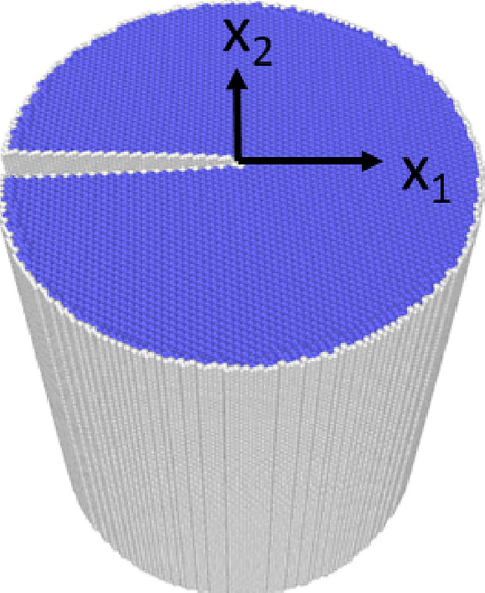
Figure 2. Cylindrical simulation space for the stress intensity factor analysis, where the radius of the cylinder is 130 Å, and the height of the cylinder is the color is assigned by the common neighbor